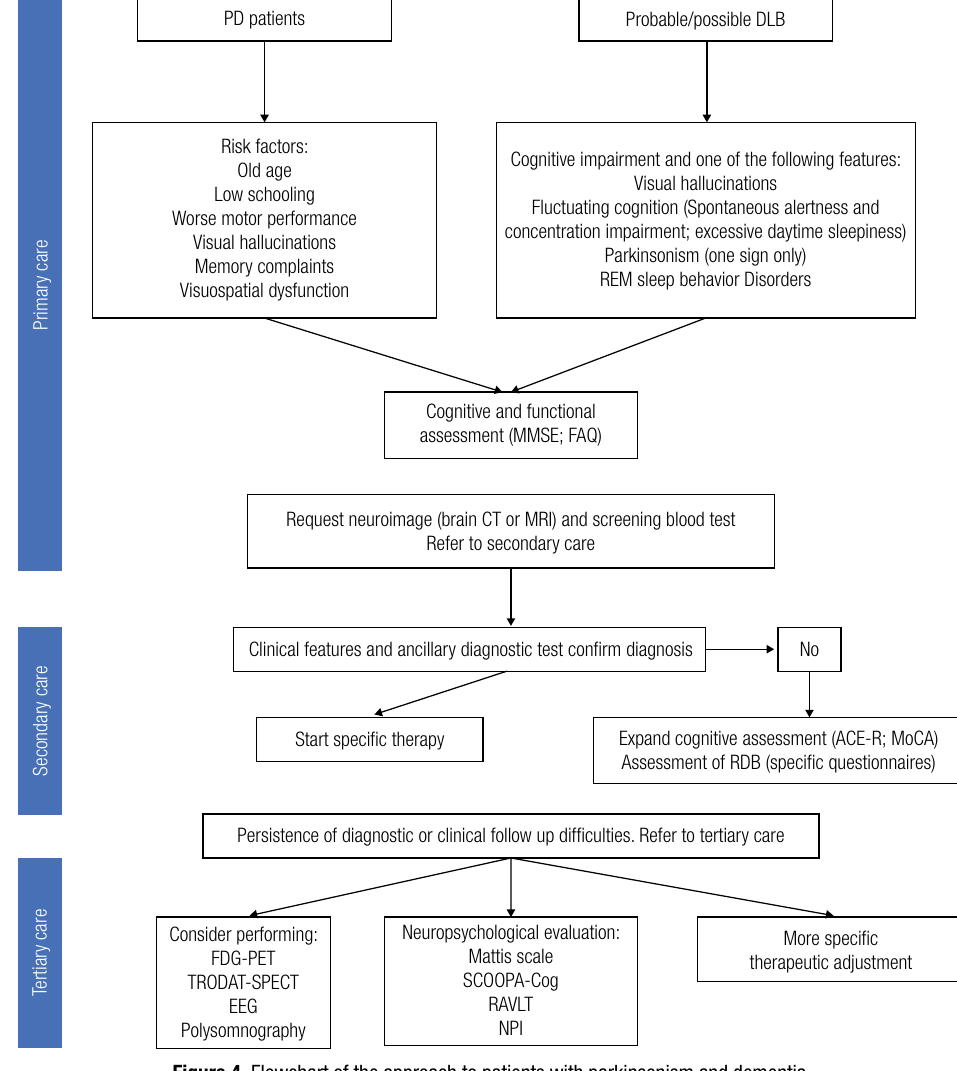
Figure 4. Flowchart of the approach to patients with parkinsonism and